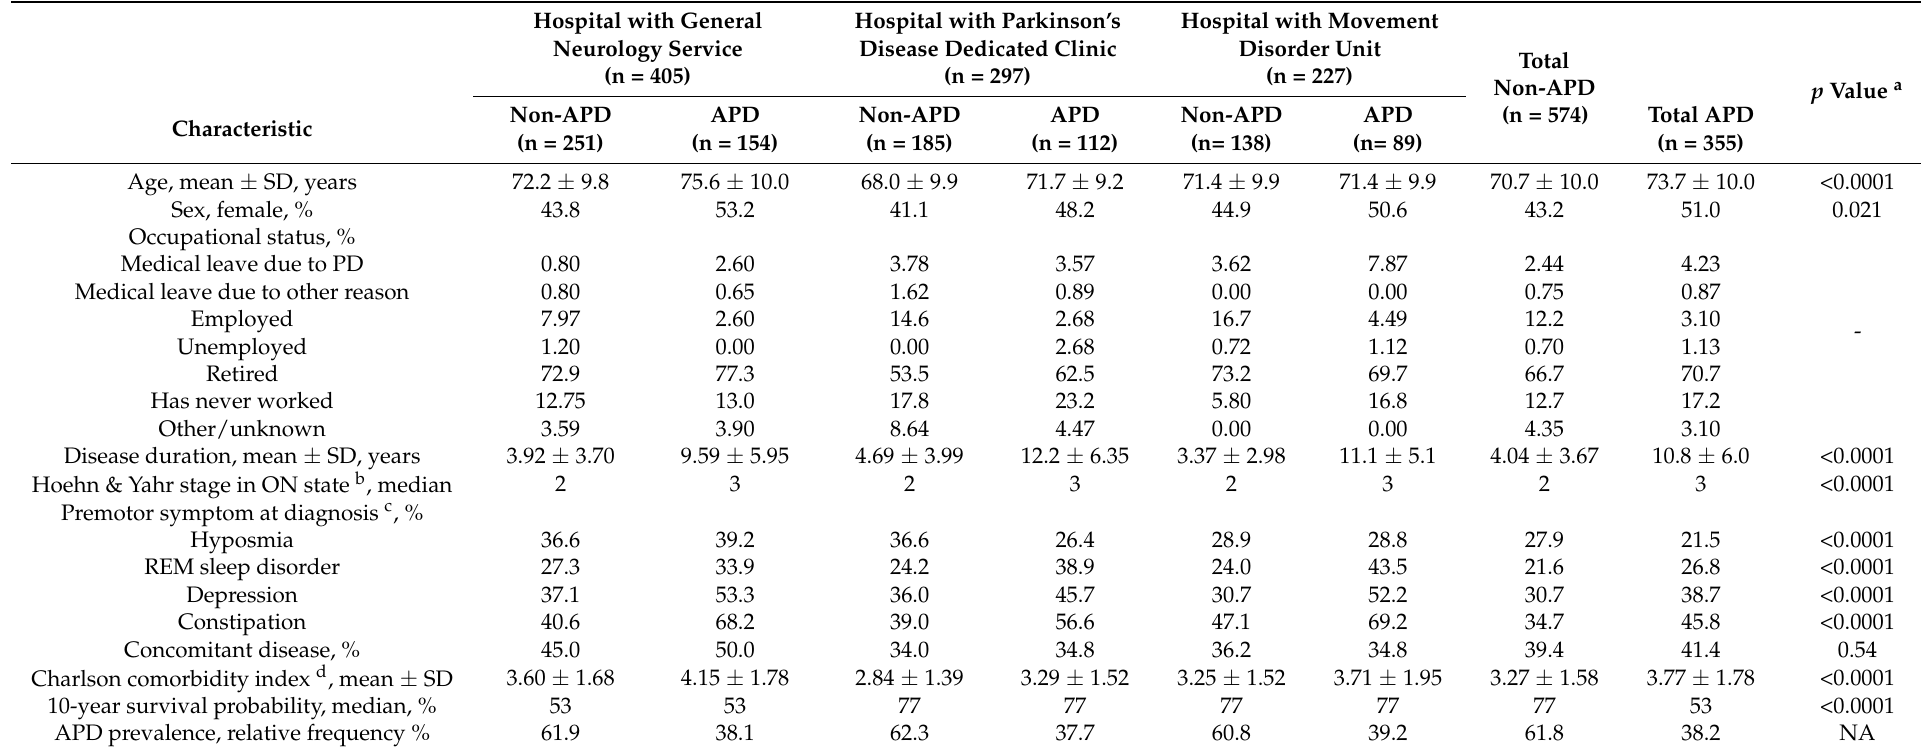
Table 2. Clinical and sociodemographic characteristics of patients with non-APD and APD, according to hospital type. Hospital with General Hospital with Parkinson’s Hospital with Neurology Service Disease Dedicated Clinic (n = 405)